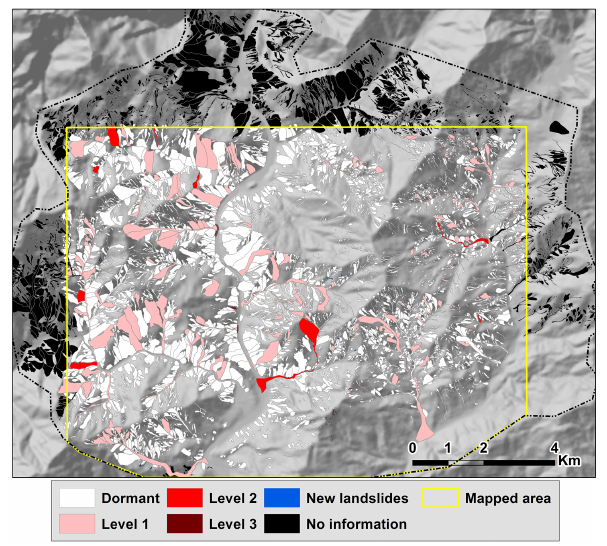
Figure 9. Landslide inventory map based on the image taken in April 2013, reflecting the state of activity after the rainy seasons of 2011 and 2012. The actual mapped area was limited within the yellow polygon due to the smaller area covered by the available Pleiades image.